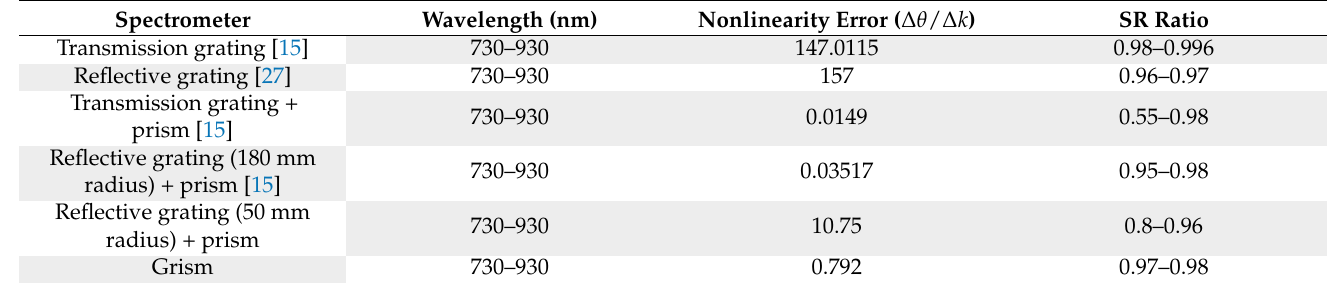
Table 1. Summary of the designed spectrometers.